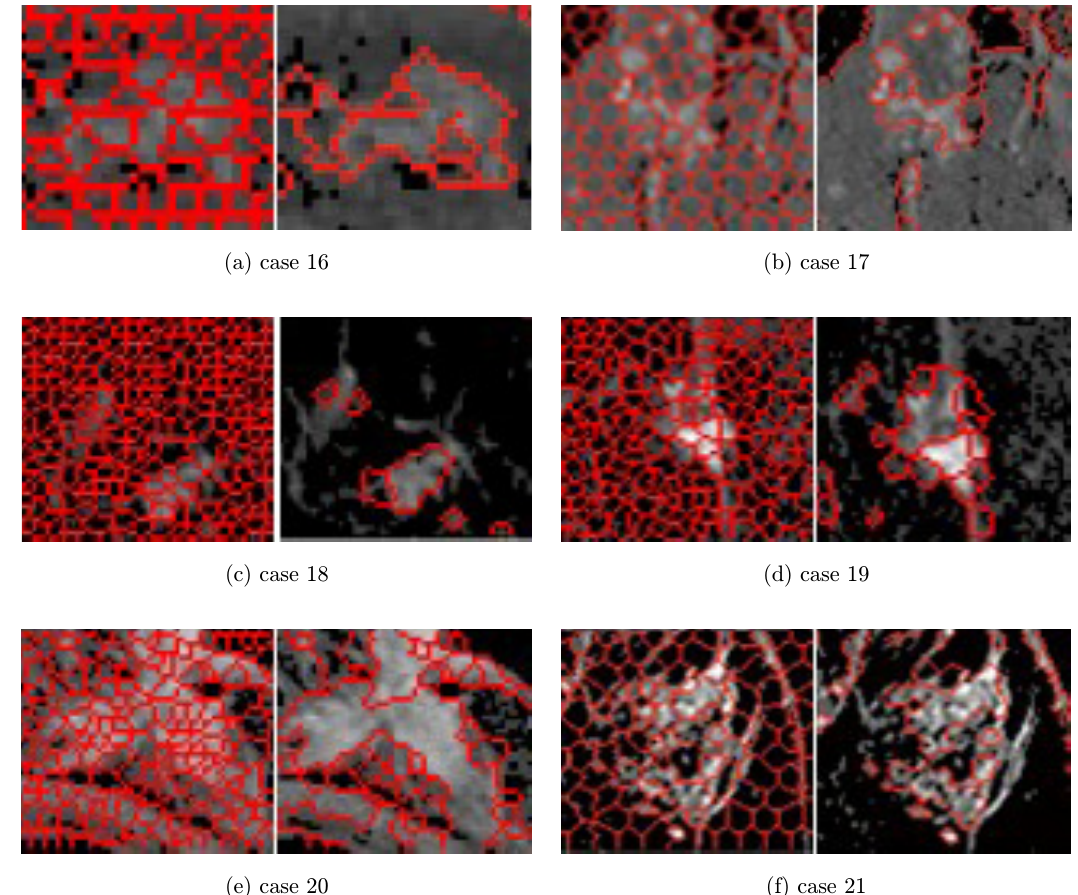
Fig. 4. SLIC (left) and DBSCAN (right) segmentation of six nonmass tumors based on m ¼ 15 and dist ¼